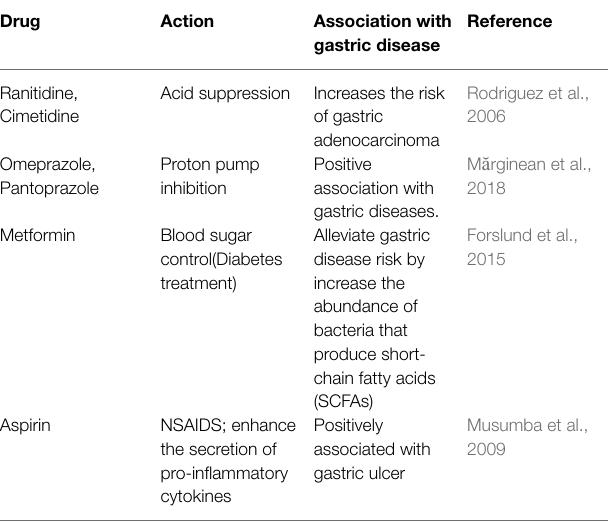
TABLE 6 | Drugs that affect gastric health and their mode of